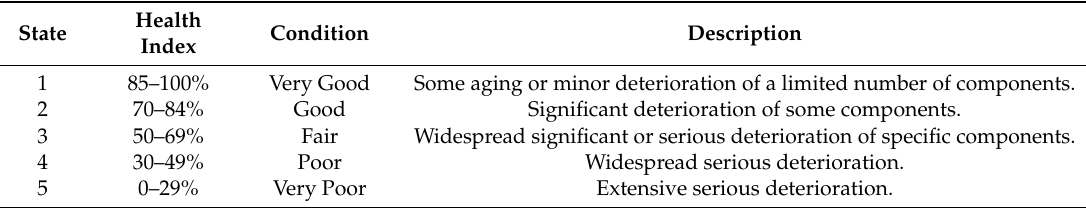
Table 1. HI indicator scales and states (adapted from